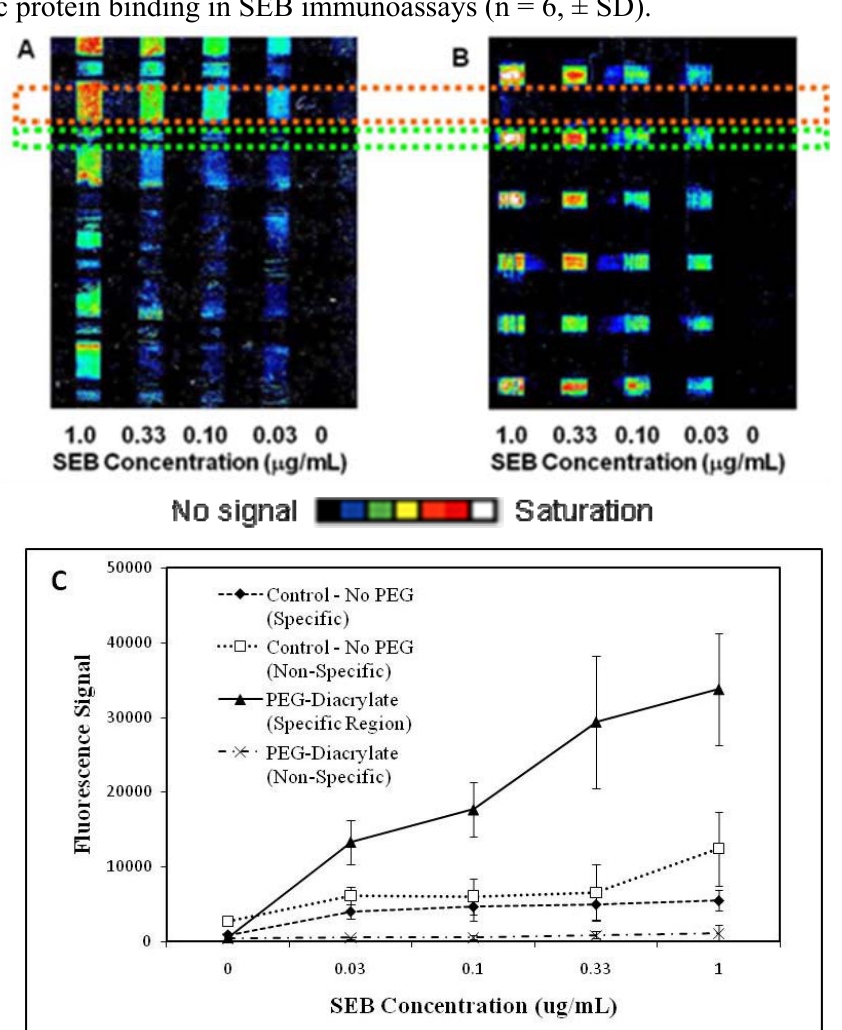
Figure 2. Patterned fluorescence array images of sandwich immunoassay for SEB using galactose-based hydrogels. (a) Representative image of SEB immunoassay using hydrogel containing no PEG. (b) Representative image of SEB immunoassay with PEG-diacrylate- modified hydrogel. SEB concentrations ranged from 0.03 to 1.0  g/mL. Regions highlighted with the orange box indicate areas of non-specific protein adsorption, whereas green-highlighted areas indicate immobilized capture antibody and represent target- specific binding regions. (c) Line plot showing fluorescence signals due to non-specific and specific protein binding in SEB immunoassays (n = 6, ±